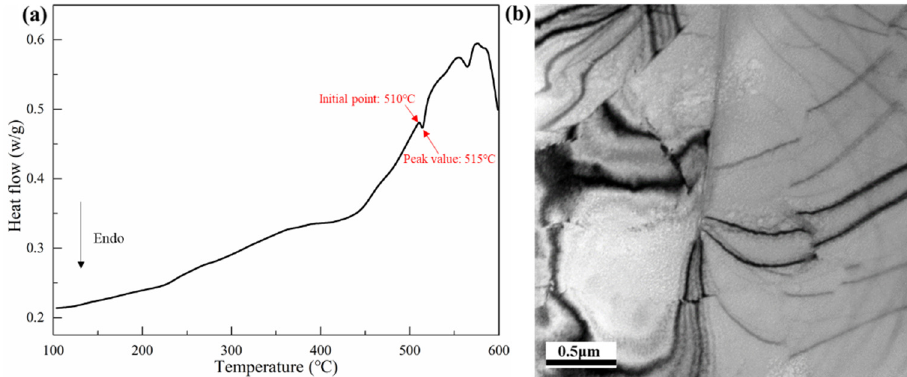
Figure 3. Dimensions of the uniaxial tensile-test sample (mm).